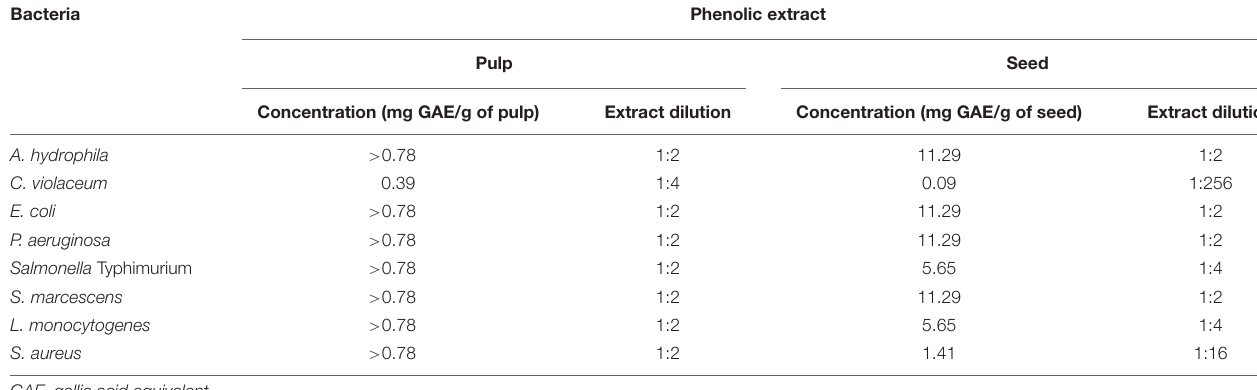
TABLE 2 | Minimum inhibitory concentration (MIC) of the pulp and seed phenolic extracts of S. cumini (L.) Skeels against the evaluated bacteria. Bacteria Phenolic extract Pulp Seed Concentration (mg GAE/g of pulp) Extract dilution Concentration (mg GAE/g of seed) Extract dilution